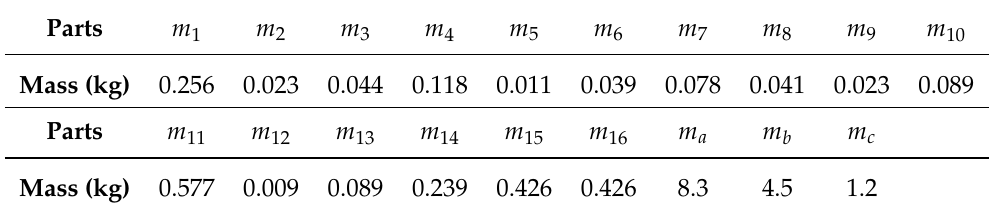
Table 6. Mass of each component and lower